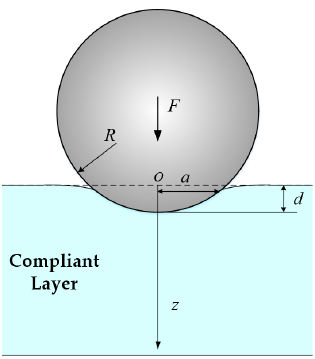
Figure 3. Hertz contact model of rigid sphere and elastic semi-space.